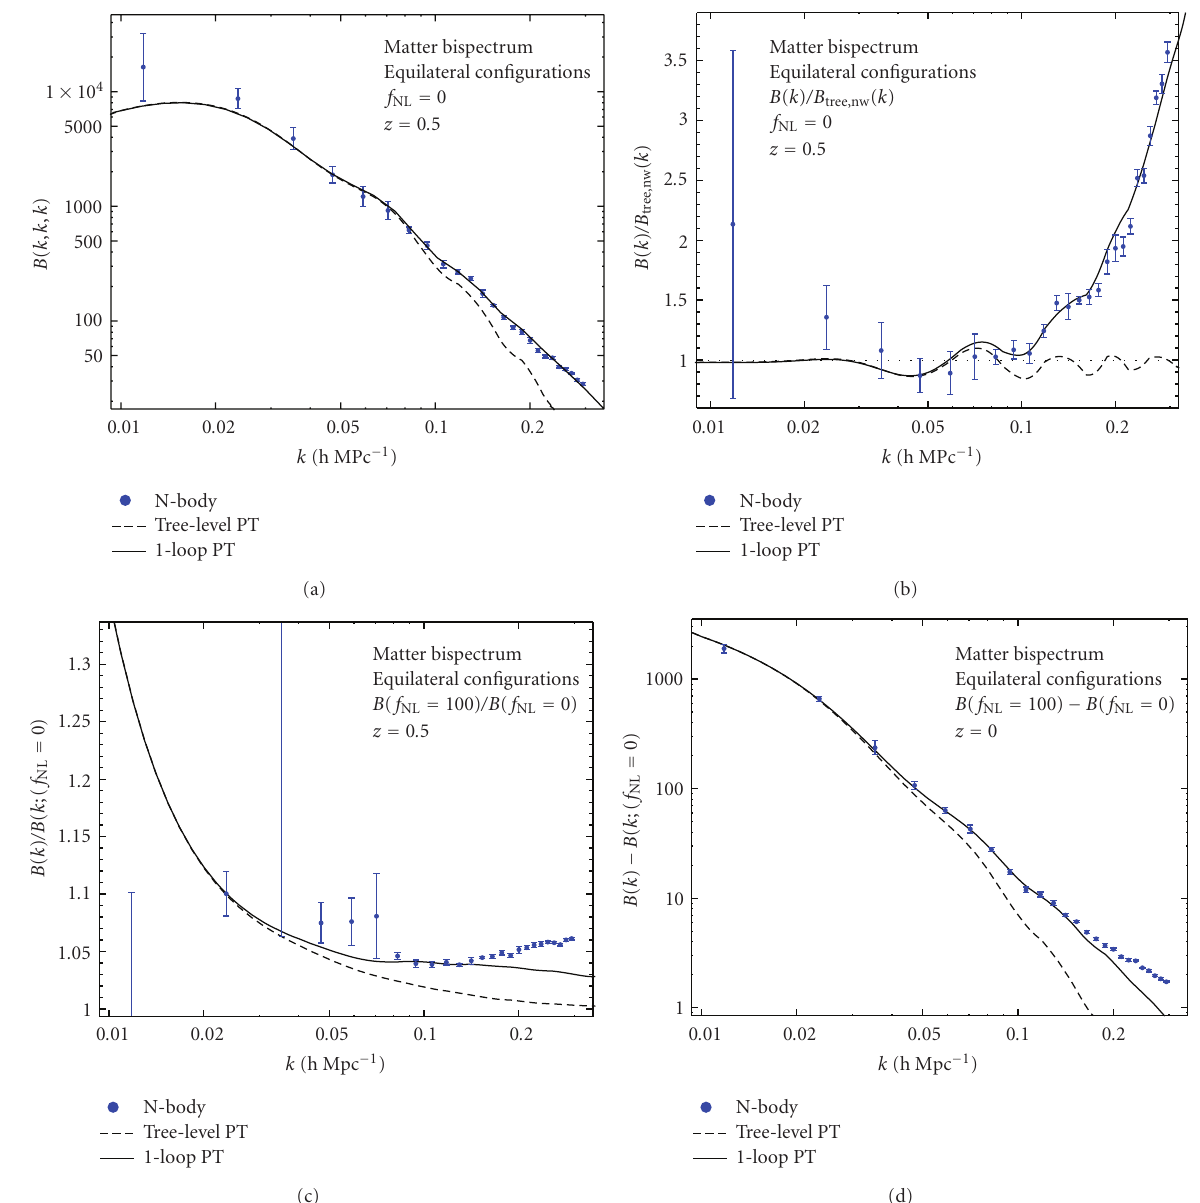
Figure 17: (a), (b) Equilateral configurations of the matter bispectrum measured in N-body simulations with Gaussian initial conditions ( data points ) and tree-level ( dashed lines ) and one-loop ( continuous lines ) predictions in perturbation theory. (b) shows the ratio to the tree-level prediction with acoustic oscillations removed. (c), (d) Ratio (c) and di ff erence (d) between the matter bispectrum measured in realizations with local non-Gaussian initial conditions ( f NL = 100) and the Gaussian case, compared with PT predictions, from